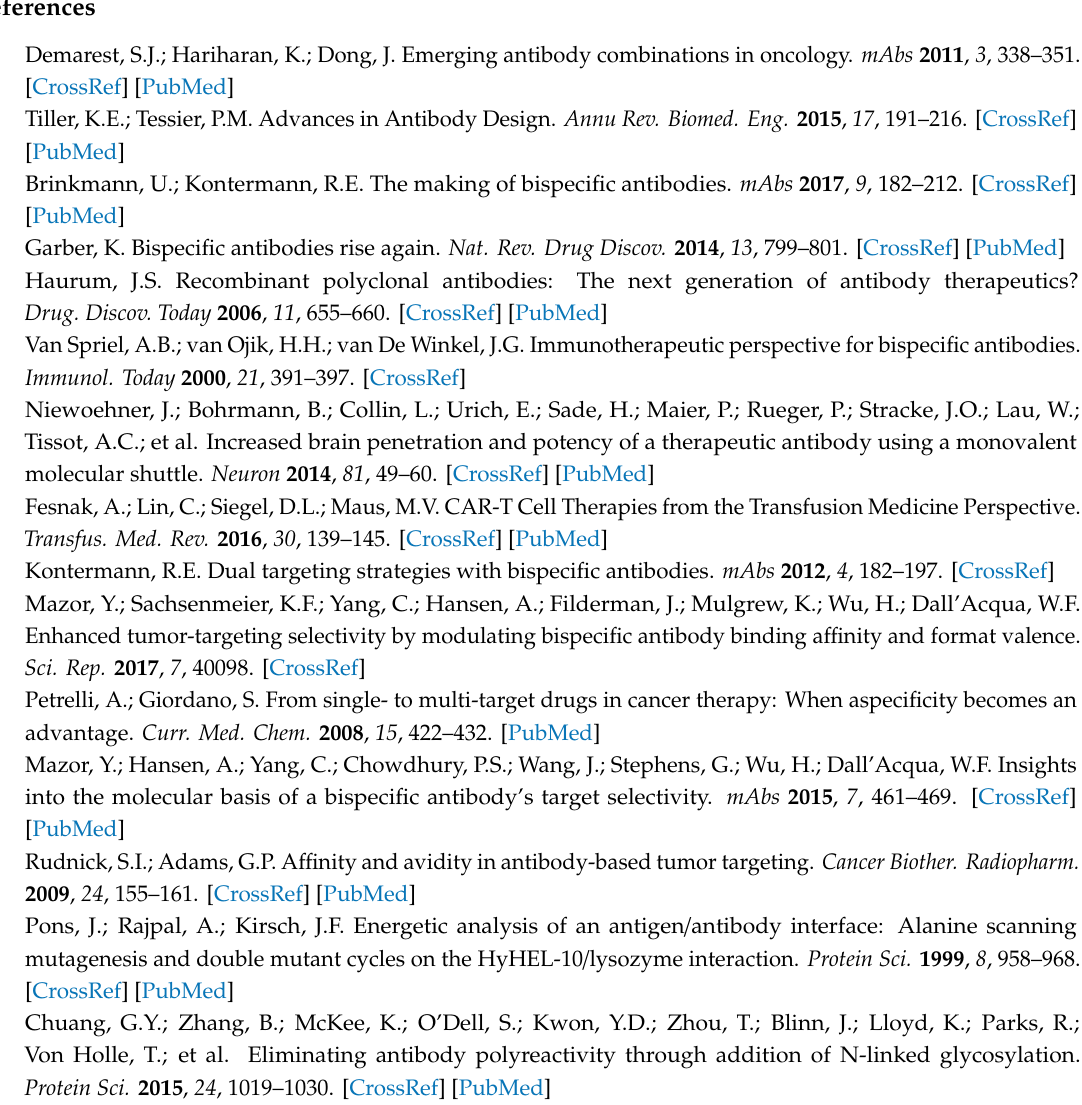
Figure S1: Analytical verification of B2G variants, Figure S2: SPR Plots of all a ffi nity measurements, Figure S3: SPR Plots of all Avidity measurements, Figure S4: Polyreactivity assays of < Her2 / neu > and < EGFR > B2G variants, Figure S5: Polyreactivity assays of < CD138 > variants, Table S1: Expression rates of antibodies and their B2G variants, Table S2: A ffi nity modulation by B2G, Table S3: Avidity modulation by B2G, Table S4: Expression yields of antibody derivatives that harbor alanine at B2G-defined CDR positions, Data S1: Di ff erentiation of CDR residues by addressing probability of antigen